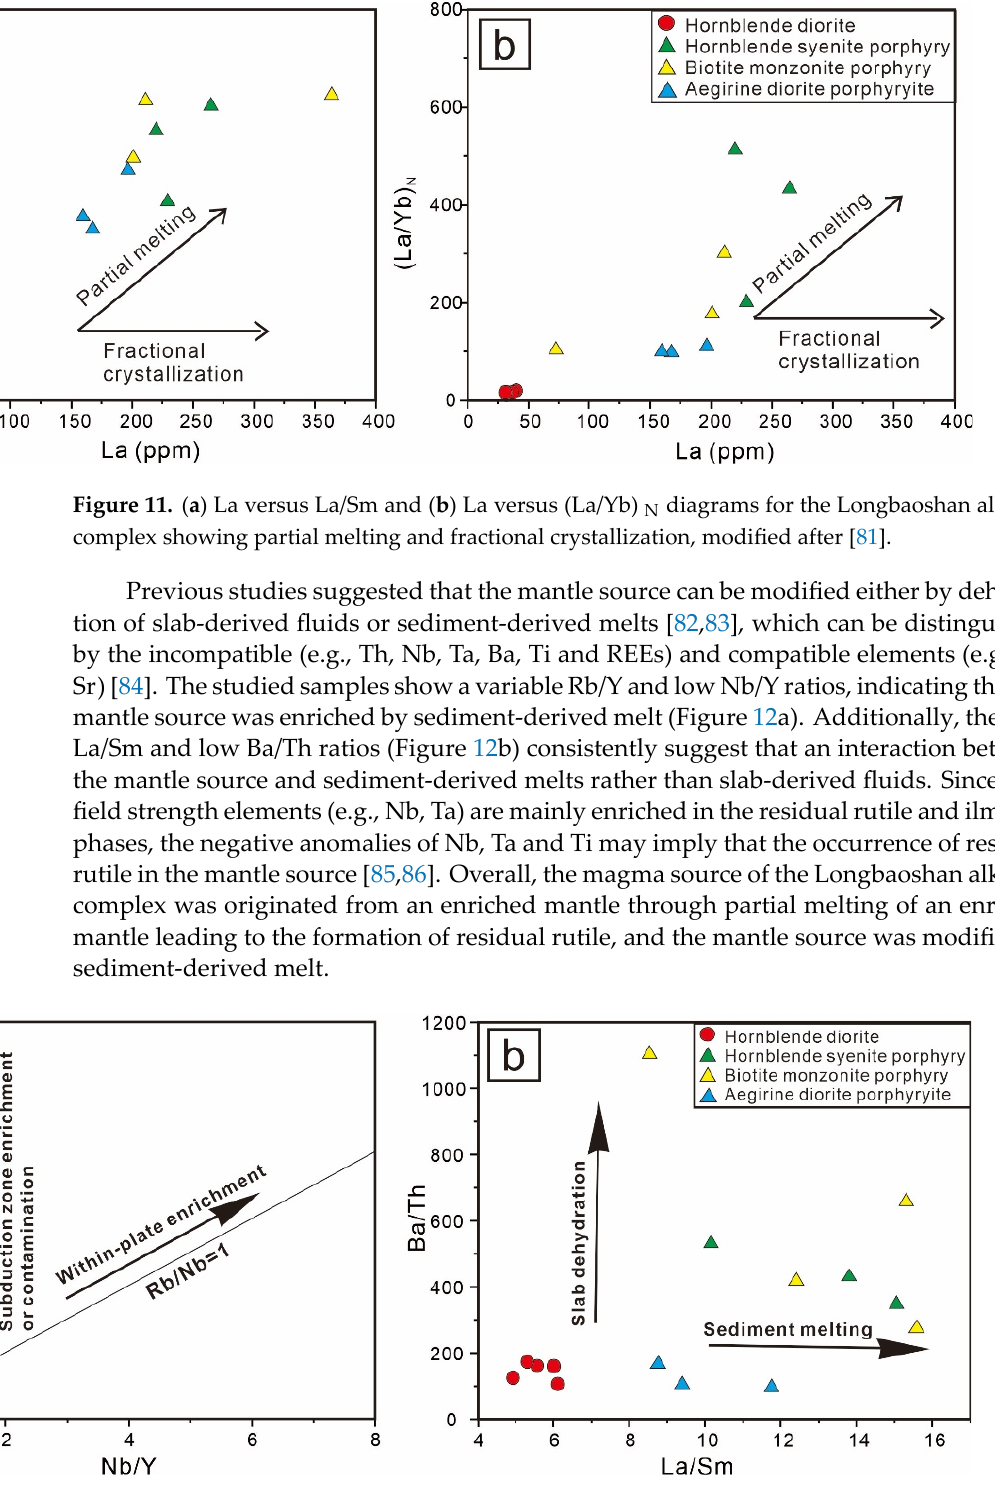
Figure 12. ( a ) Nb/Y versus Rb/Y diagram, modified after [87]. ( b ) La/Sm versus Ba/Th diagram, modified after [87].